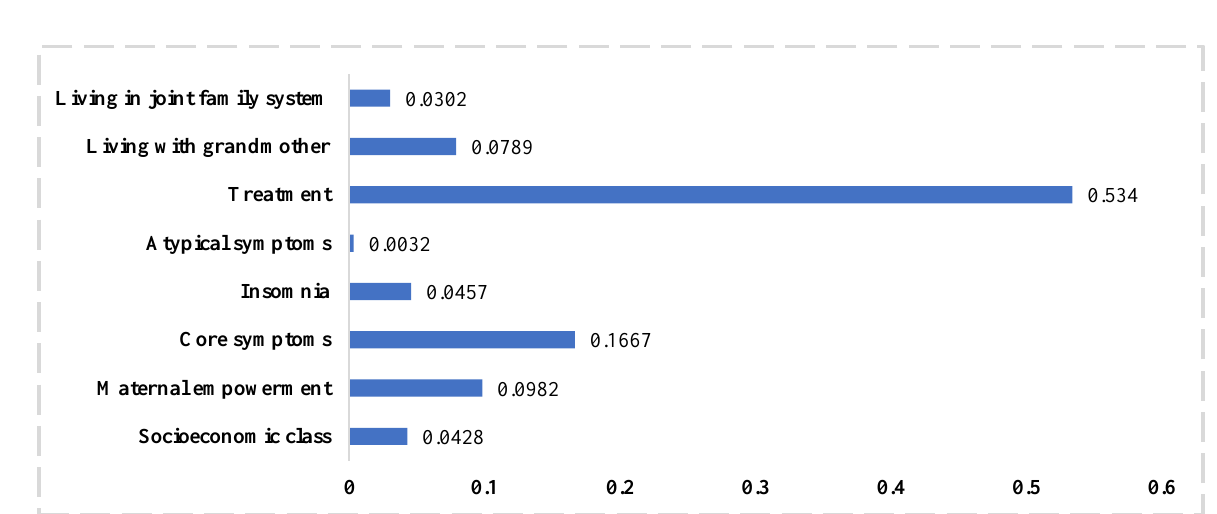
Figure 1. Importance of predictors in the final model presented as standardized dominance statistic. The overall model performance was adequate. The model yielded a c-statistic of 0.75 (95% CI: 0.71 to 0.78), indicating good discrimination (Figure 2). Several calibration measures were used to assess whether the model predictions’ accuracy matched the observed data. In the development data, the ratio of expected and observed number of events was 99.7%, CITL at 0, and a calibration slope of 1. Calibration plot with LOWESS smoother indicated a good-fitted model by visualizing the observed and expected probability of outcome among 10 high-risk groups (Figure 3).